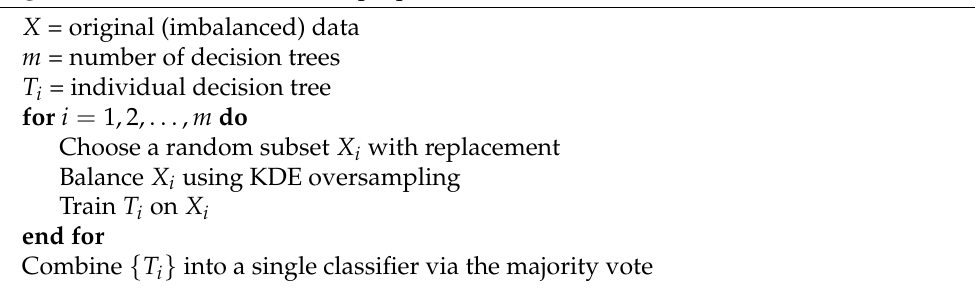
Algorithm 1 Pseudocode for the proposed KDE ensemble classifier